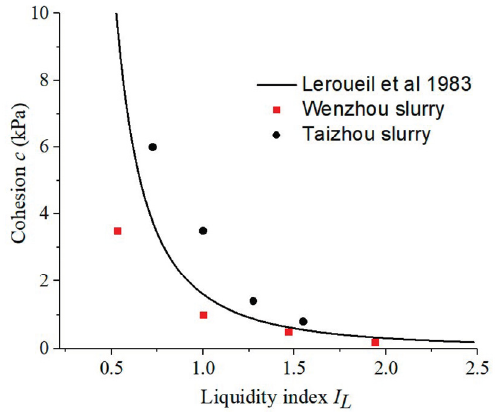
Figure A1. Comparisons of the slurry cohesion between the predictions of Equation (5) and test results by micro vane ‐ shear apparatus [25].